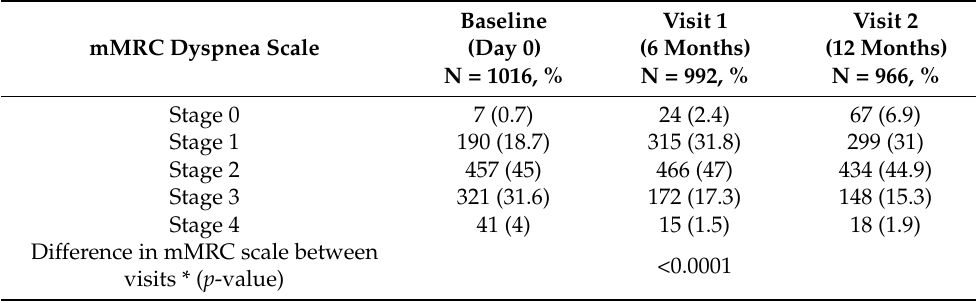
Figure 4. ( a ) Distribution of the total number of patients per visit based on mMRC dyspnea scale; ( b ) Distribution of patients without comorbidities per visit based on mMRC dyspnea scale; ( c ) Distri- bution of patients with comorbidities per visit based on mMRC dyspnea scale; ( d ) Distribution of patients with cardiovascular and/or metabolic comorbidities per visit based on mMRC dyspnea scale. Table 6. mMRC dyspnea scale at 0, 6 and 12 months and difference between study visits for the total number of